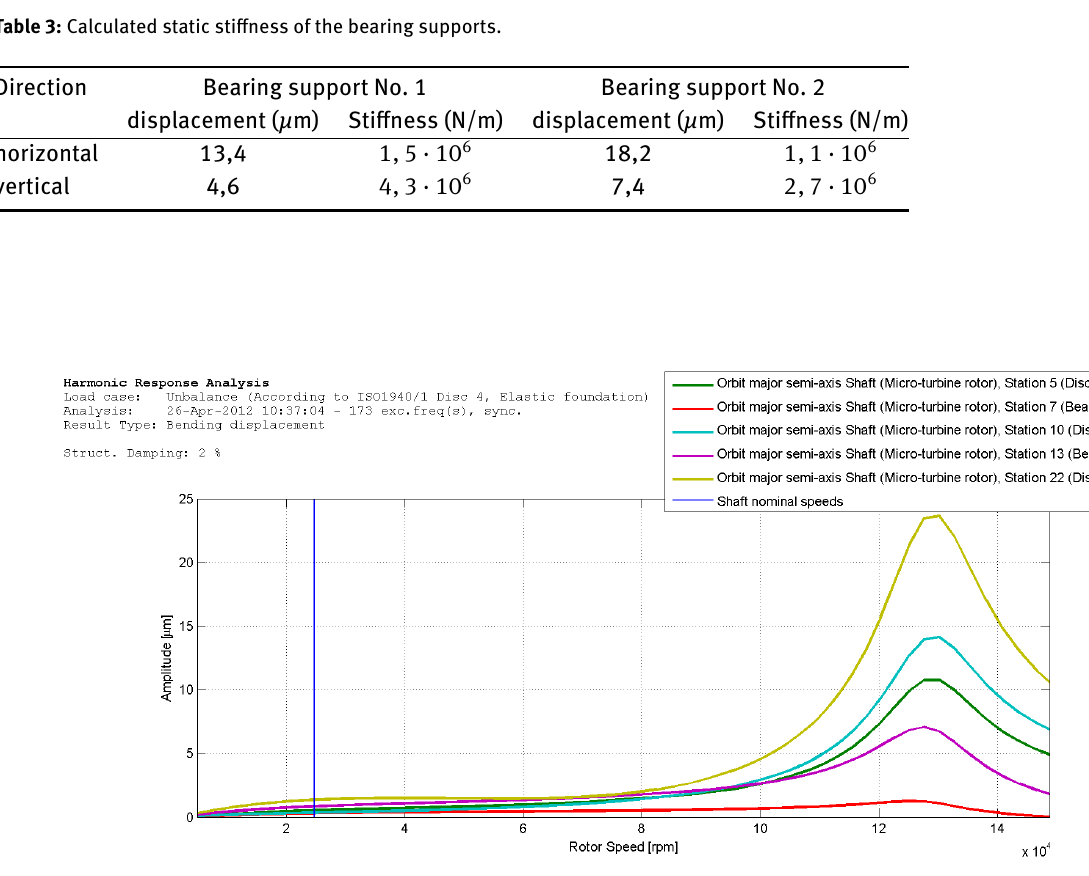
Figure 18: Amplitude of the rotor vibration taking into account the compliance of the bearing